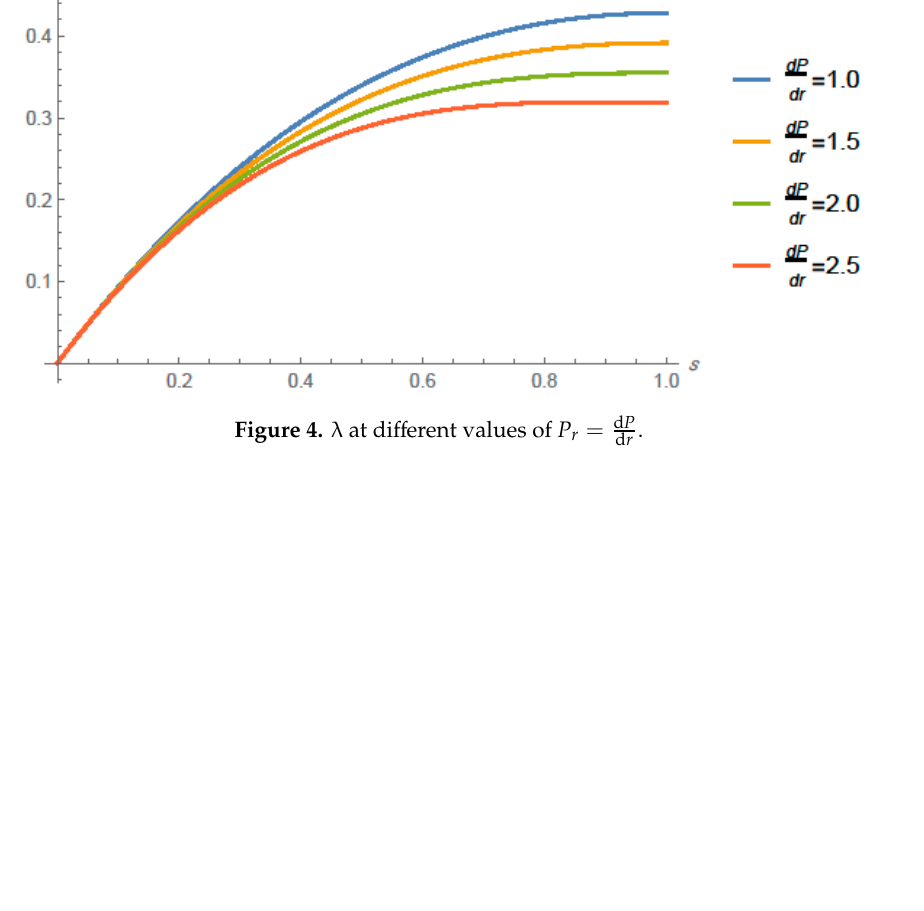
( d ) Figure 5. λ at different values of 𝑃 (cid:3045) and 𝑠 . ( a ) with the s range of [0–2]; ( b ) with the s range of [0–3]; ( c ) with the s range of [0–7]; ( d ) with the s range of [0–12]. For fixed value of β = 0.03 and for different values of 𝑃 (cid:3045) , the values of constant 𝐶 (cid:2869) are shown in the Table 2. the values of 𝑢 are calculated as shown in the Equations (40)–(43). 𝑢 ((cid:3017) (cid:3293) (cid:2880)(cid:2869)) = 1 + 𝑠[𝑠{𝑠(0.0665085 − 0.0110848𝑠) + 0.350356} − 1.40578],